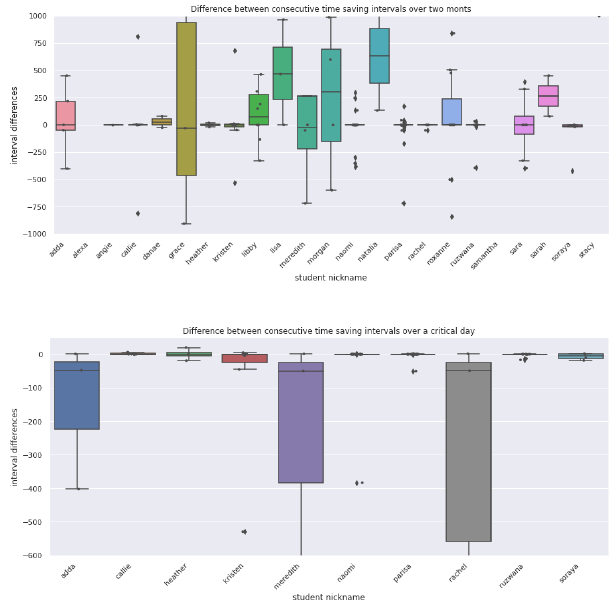
Figure 9. Differences between saving